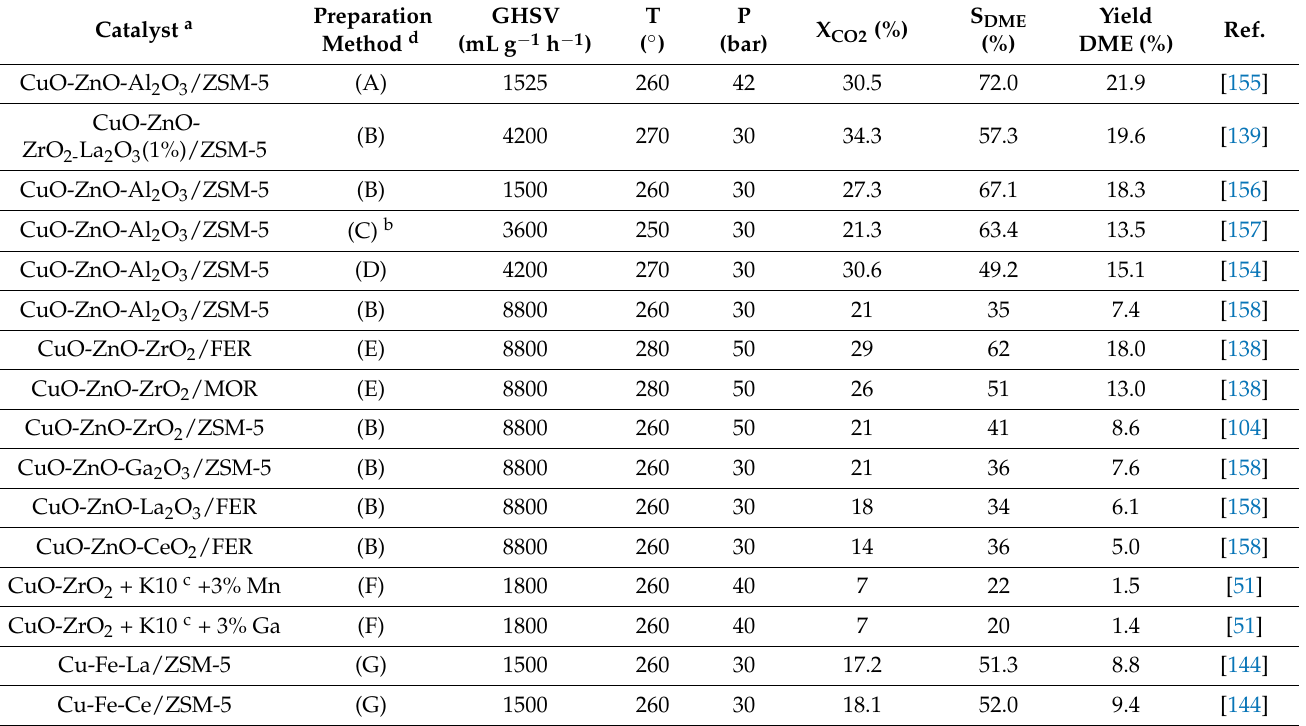
Table 2. Activity of selected hybrid and bifunctional catalysts based on Cu for direct DME synthesis from CO 2. Catalyst a